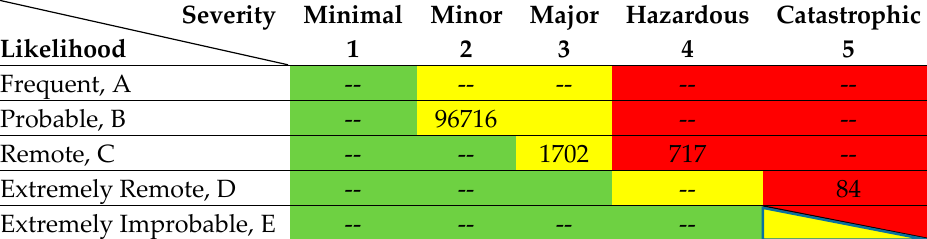
Table 17. Alert probability summary, overtaking encounter.